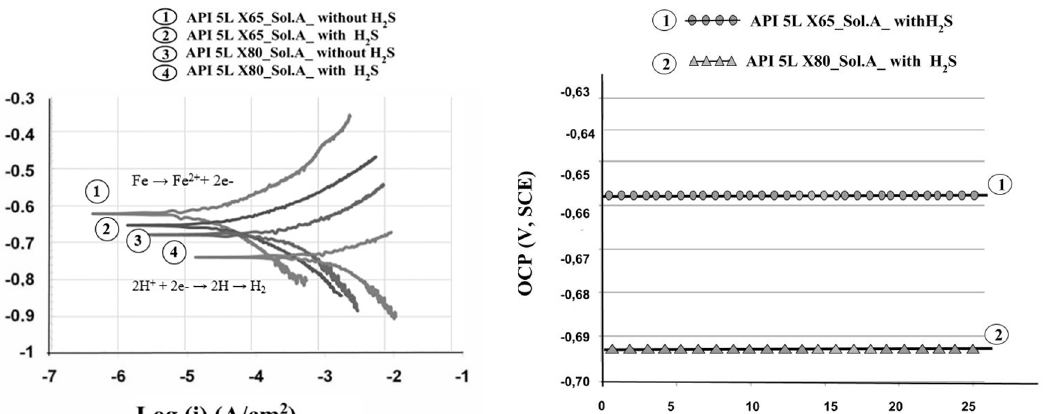
Figure 6. Nyquist (a) and phase angle (b) diagrams of API 5L X65 and API 5L X80 steels in deaerated solution A, NACE TM0284 (2011), without and with H S saturation. Experimental Procedure 1. 2